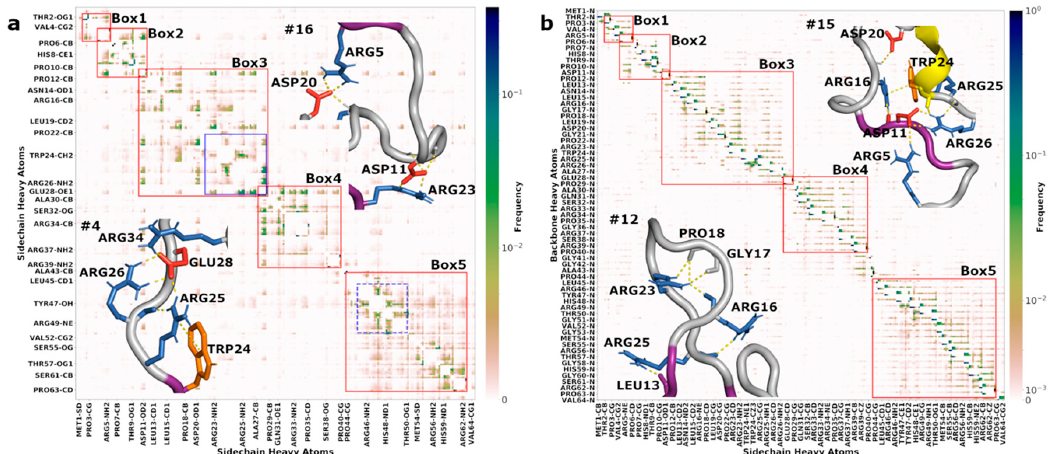
Figure 5. Contact maps between ( a ) sidechain–sidechain and ( b ) sidechain–backbone atom pairs. Normalized contact frequencies are shown as color gradients, which follow a linear scale for contact frequencies between 0 and 0.01 but a logarithmic scale above 0.01. Red boxes indicate segments of residues that frequently form contacts. Blue boxes (solid, residues 23–28; dash, 46–50) highlight residues with particularly high contact frequencies. See an enlarged view of Box 3 and Box 5 in Figure S7. Enlarged views of regions from four conformations (#4, #12, #15, and #16) in Figure 4 are shown as insets to illustrate SC-SC and SC-BB interactions.